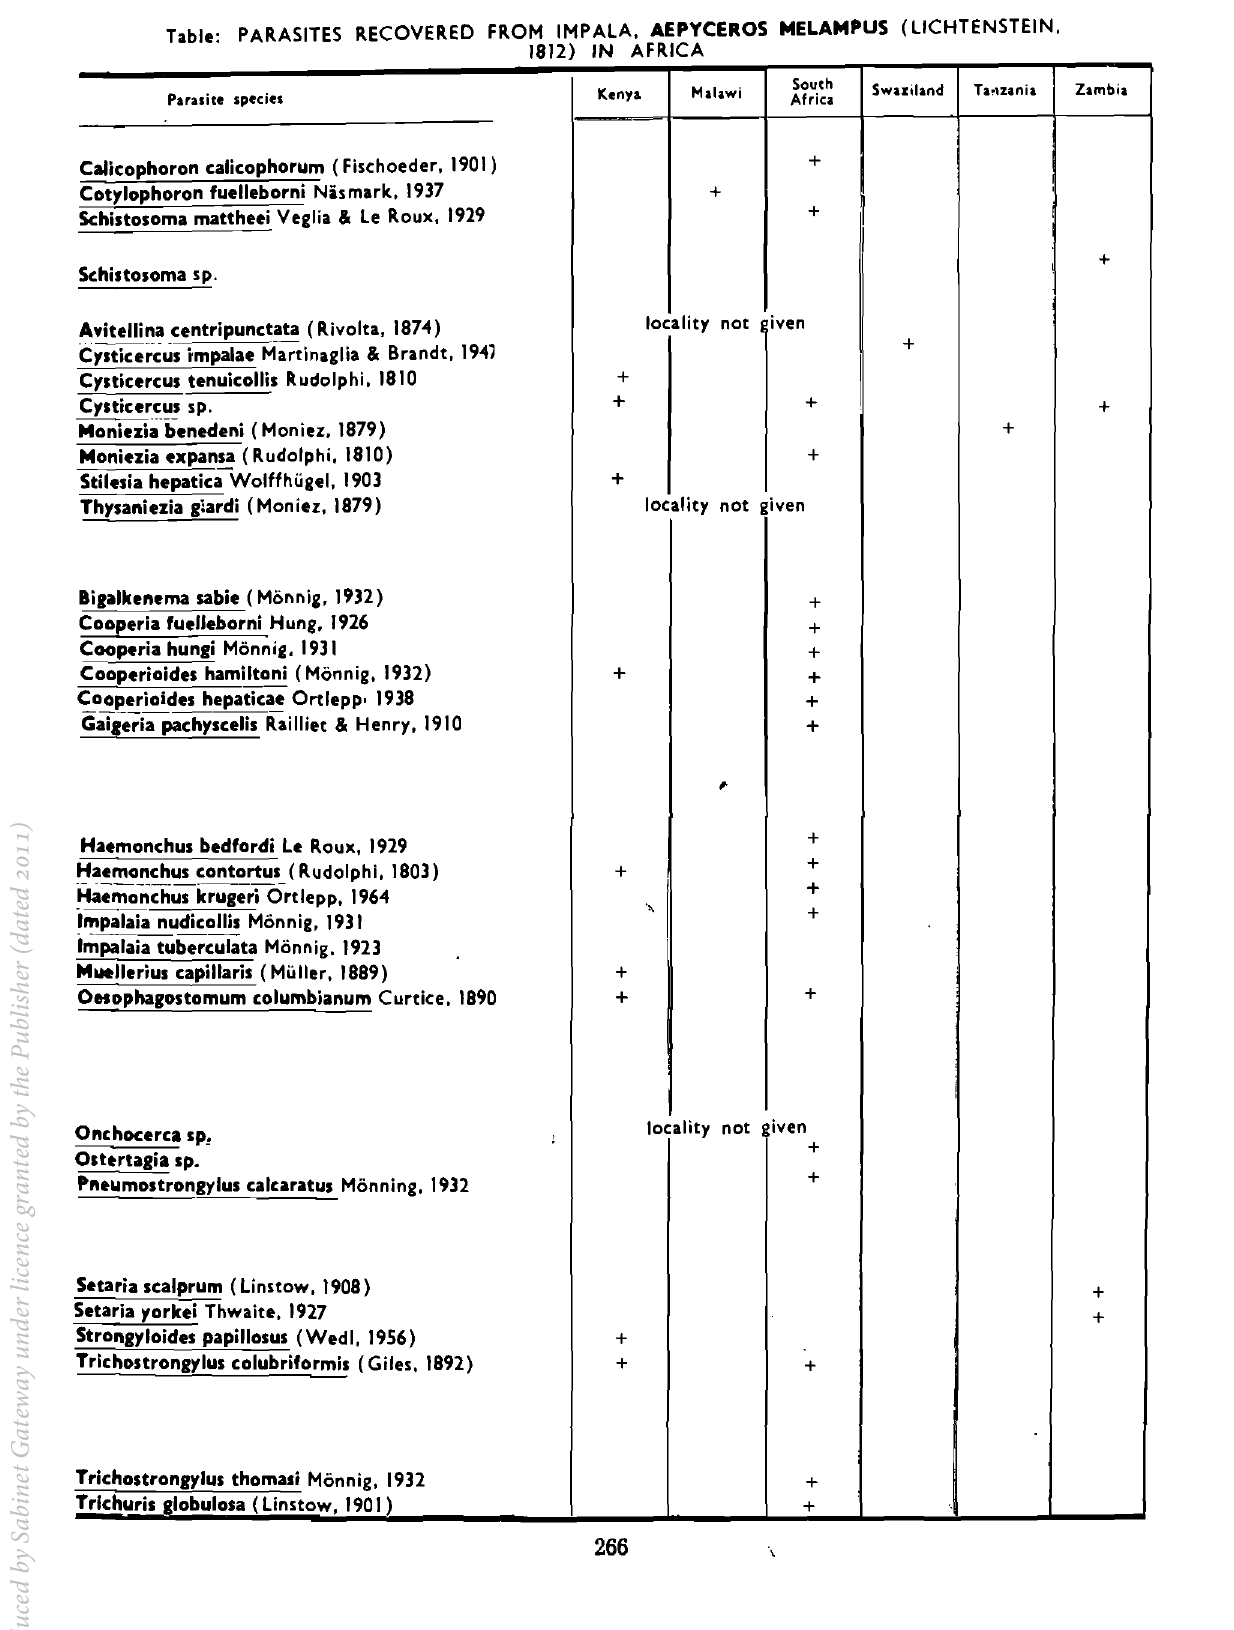
Table: PARASITES RECOVERED FROM IMPALA. AEPYCEROS MELAMPUS (LICHTENSTEIN. 1812) IN AFRICA Parasite